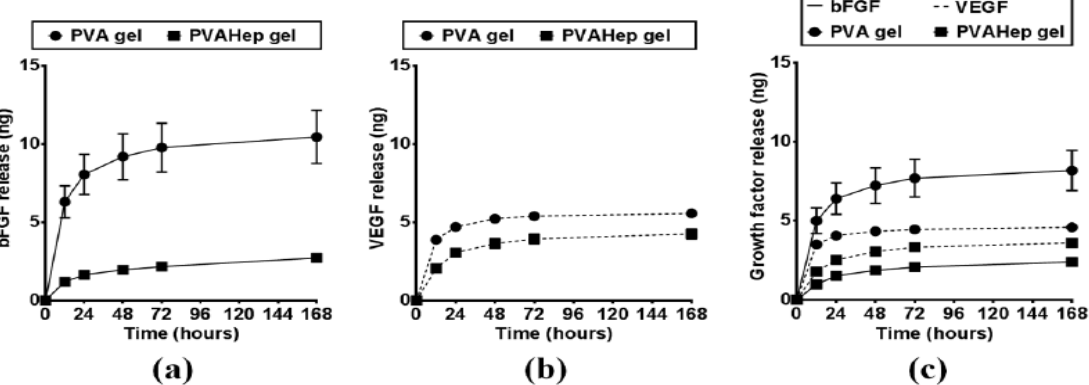
Figure 7. Growth factor release profiles from PVA and PVA-Hep gels for a period of 7 days: ( a ) bFGF release, ( b ) VEGF release, and ( c ) dual release of bFGF (solid lines) and VEGF (dashed lines) [reprinted from 300, open access].